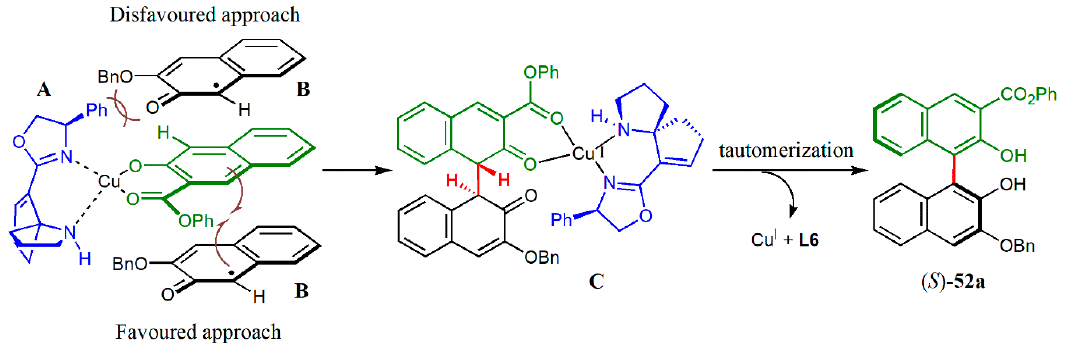
Figure 16. The stereoselectivity of the Cu-catalyzed synthesis of 3,3’-substituted C1-symmetric BINOLs.